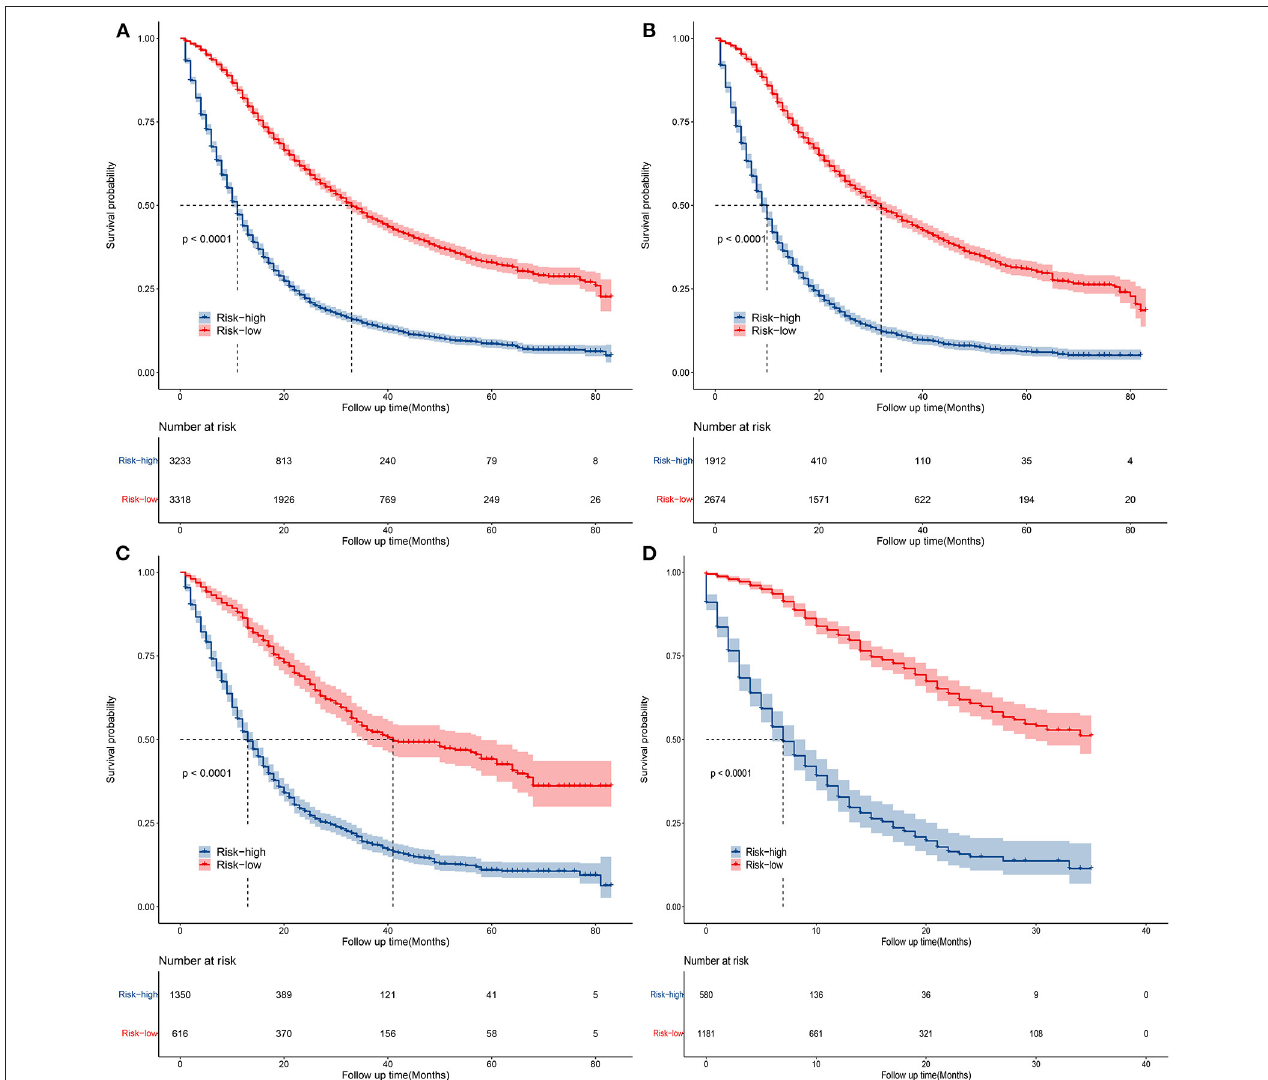
FIGURE 6 | Kaplan–Meier curves of OS for patients in the low- and high-risk groups in all cohorts (A) , training cohort (B) , validation cohort (C) , and external validation cohort (D)